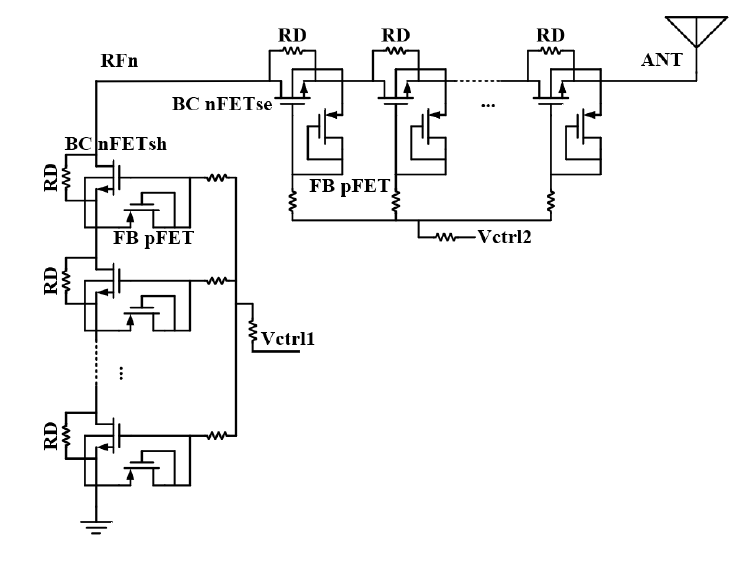
Figure 1. Proposed RF switch branch.